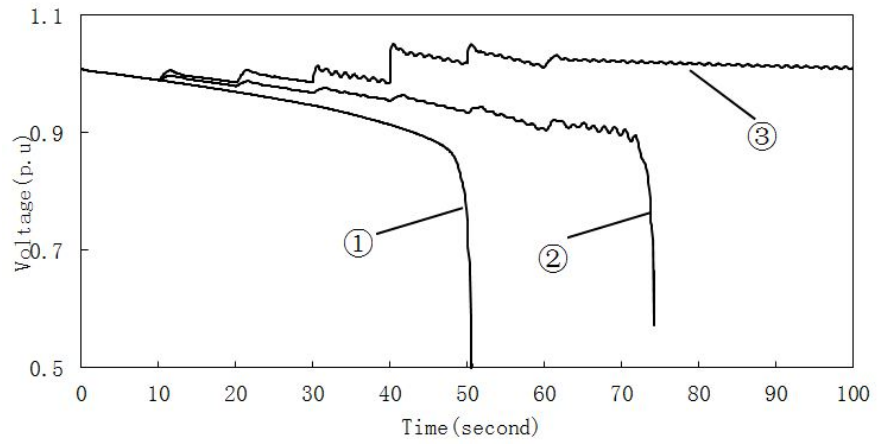
Figure 4. Voltage curve of key bus 11.